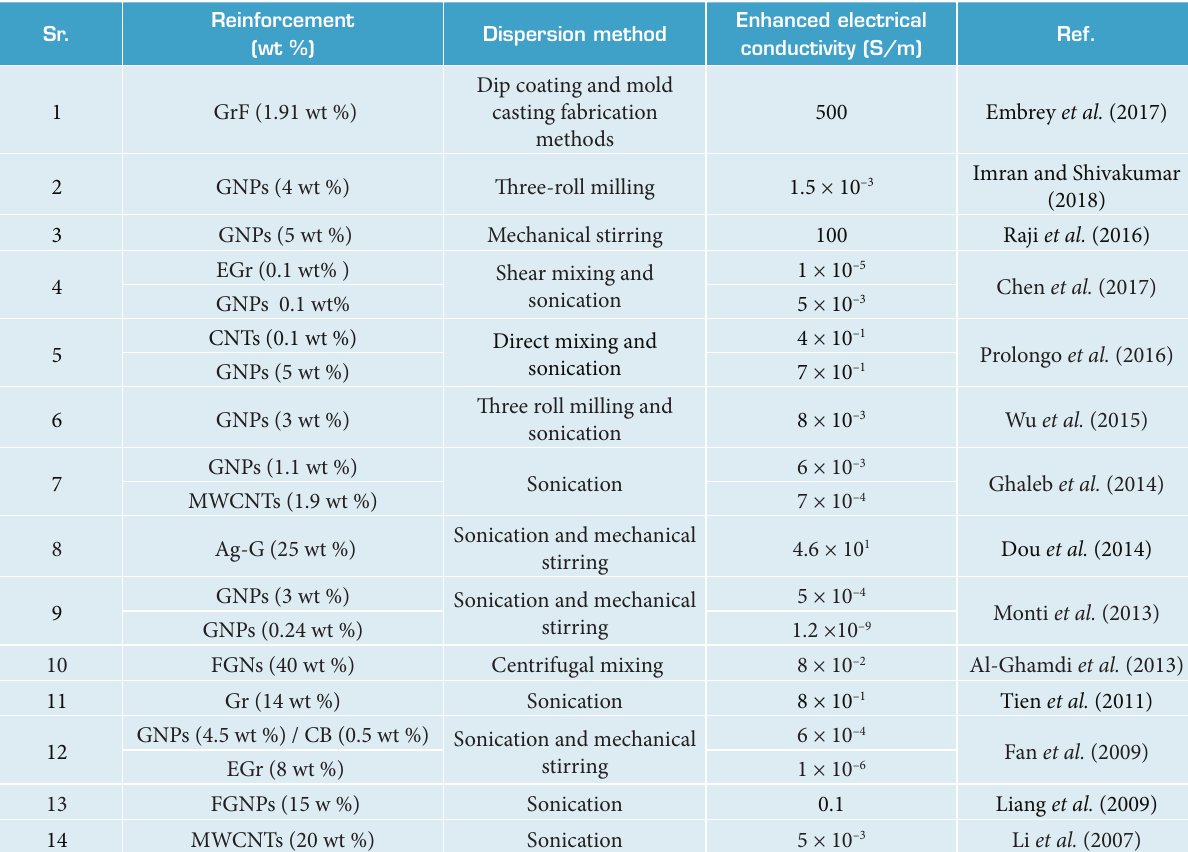
Table 2. The variation in electrical conductivity with various forms of graphene and graphite reinforced epoxy composites.